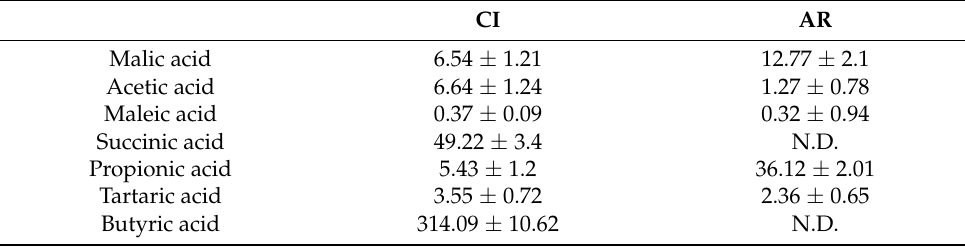
Table 2. Contents of organic acids in CI and